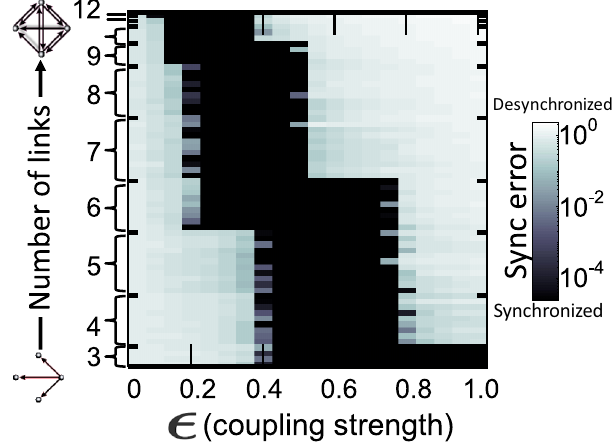
FIG. 5. Synchronization error for simulated time series of the networks in Fig. 4 realized with optoelectronic oscillator nodes with different coupling strengths for random initial conditions. The color-coded synchronization error for each of the 62 net- works in Fig. 4 is shown as one of the 62 horizontal bars for each value of the coupling strength. Here, the convention we follow is that, for a fixed number of links ( L ), moving upward, the horizontal bars correspond to the networks listed in Fig. 4 left to right. The same convention is followed in Figs. 6, 7, and